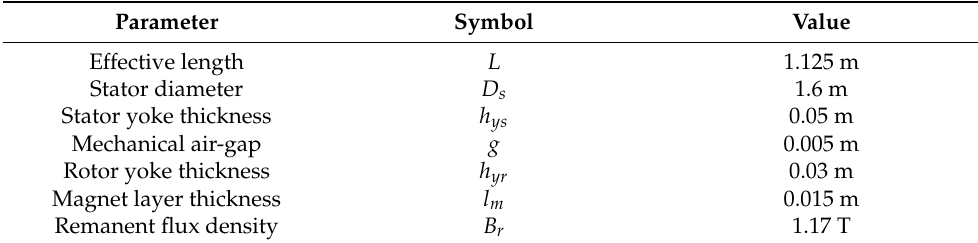
Table 1. Reference electrical machine